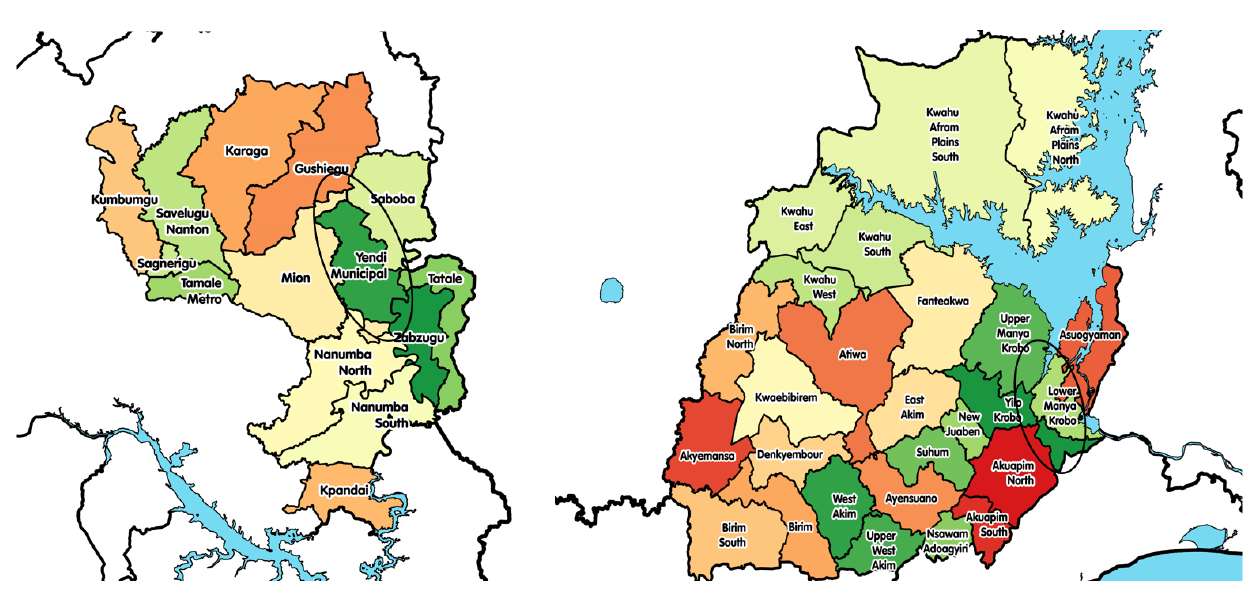
Figure 1. District Map of Northern and Eastern Regions of Ghana with study areas in the circle. Maps were adapted from original versions available from Wikimedia under a CC BY-SA 4.0 licens e (Northern region map – Rwhaun, 2018, https://commons.wikimedia.org/ wiki/File:Districts_of_the_Northern_Region_(2018).png; Eastern region map – Macabe5387, 2017, https://commons.wikimedia.org/wiki/File: